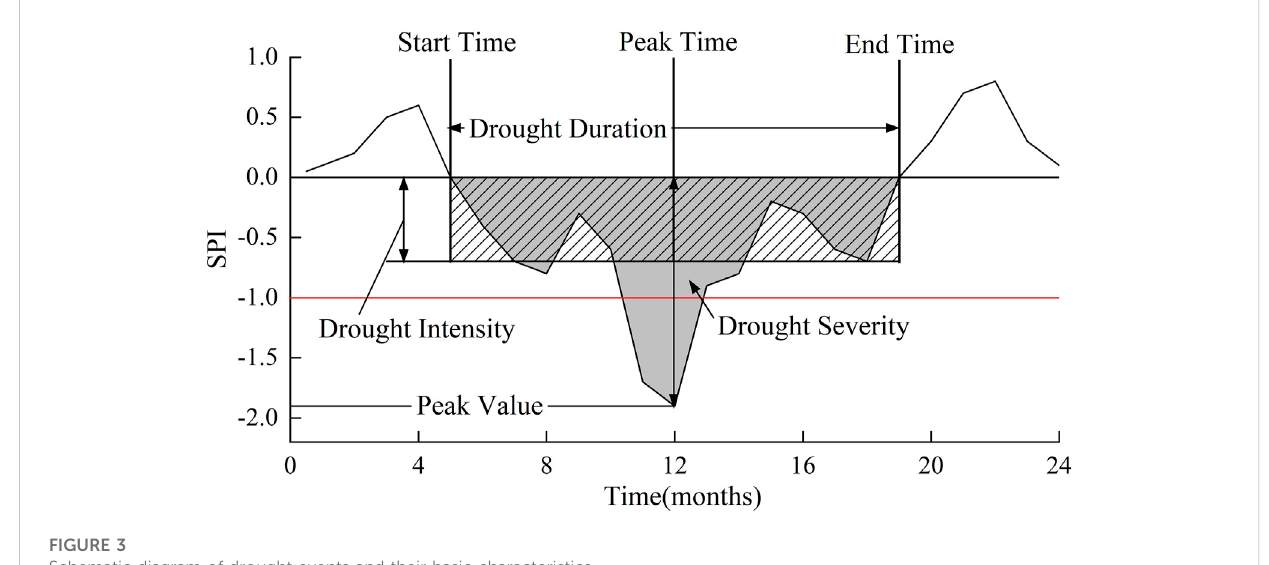
FIGURE 3 Schematic diagram of drought events and their basic